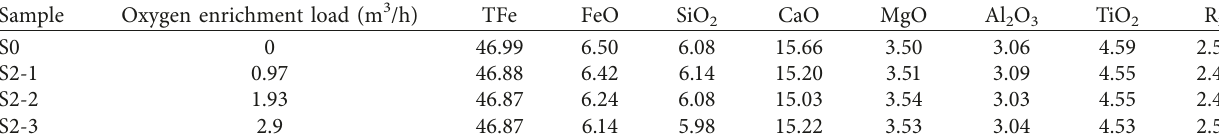
Table 9: Composition of the finished sintered ore with different oxygen enrichment loads. Sample